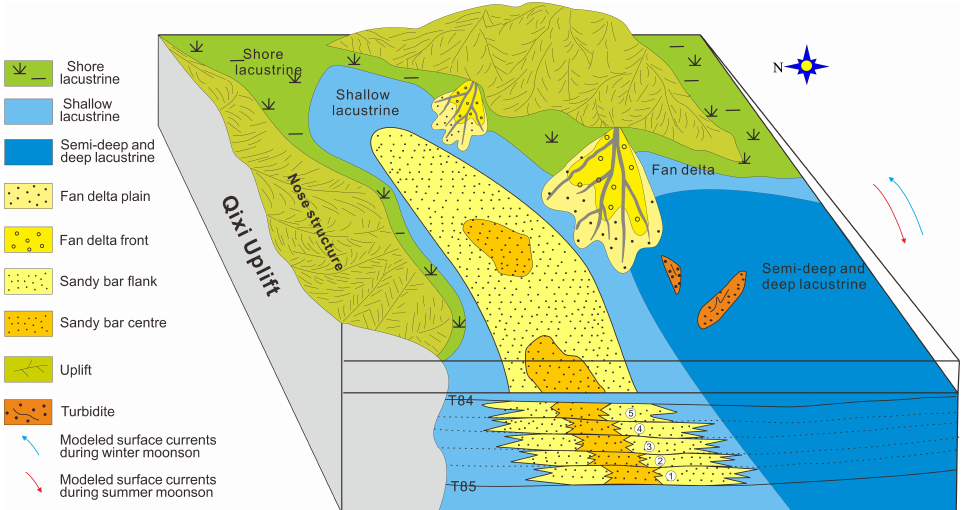
Figure 13. Depositional model for lacustrine beach-bar sand bodies in the LST stage of the Mbr2 period in the Weixinan